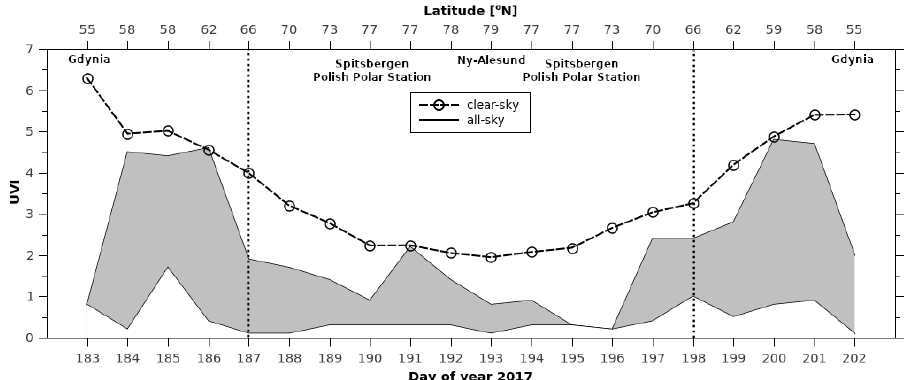
Figure 2. The modelled clear-sky UVI (dashed line) and the daily range of the measured UVI dur- ing the cruise (the shaded